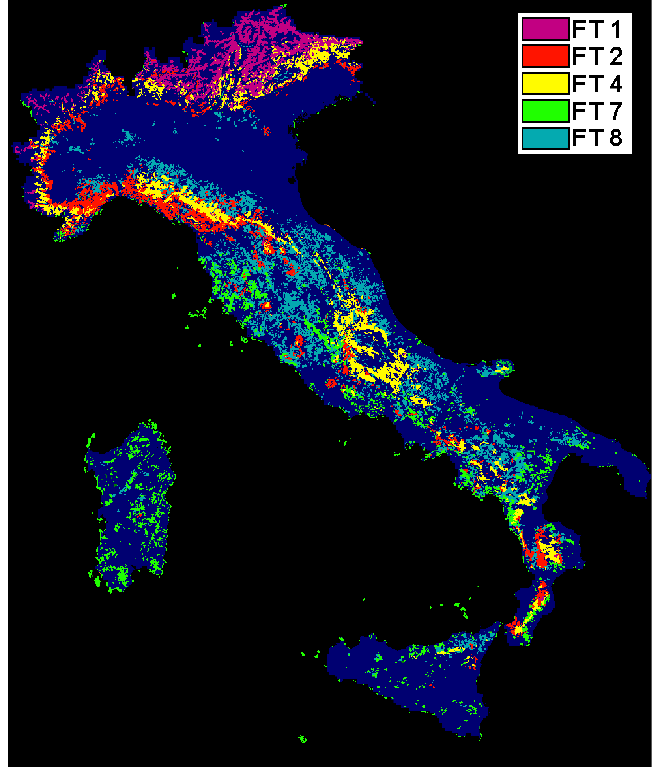
Figure 1. Spatial distribution of the five forest types considered in